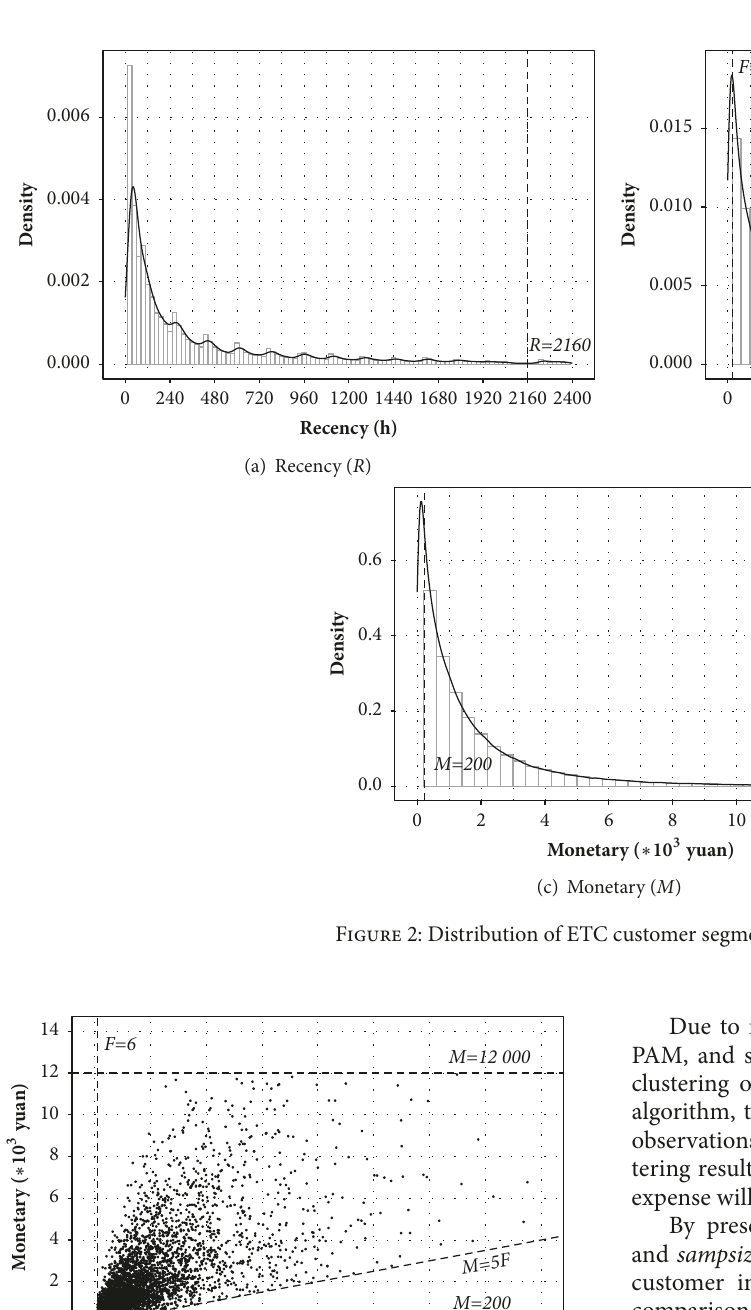
𝑘 . The calculation indicates that 𝑘 = 3 corresponded to the maximum width, so the optimal number of clusters is